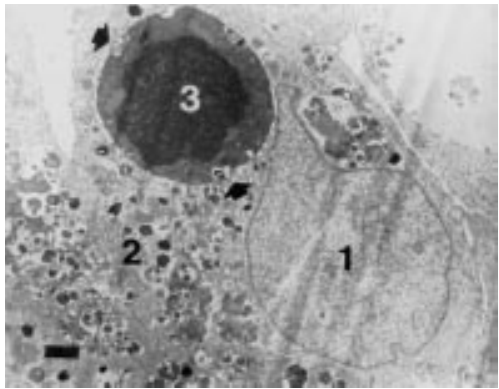
Fig. 9. Bud of a microcell in the cytoplasm of a macrocell. 1 – macronucleus, 2 – cytoplasm of the macrocell, 3 – microcell bud. Arrows point to sites of a microcell enclosing particles of the cyto- plasm of a macrocell. Bar 1.0 (cid:22) m.